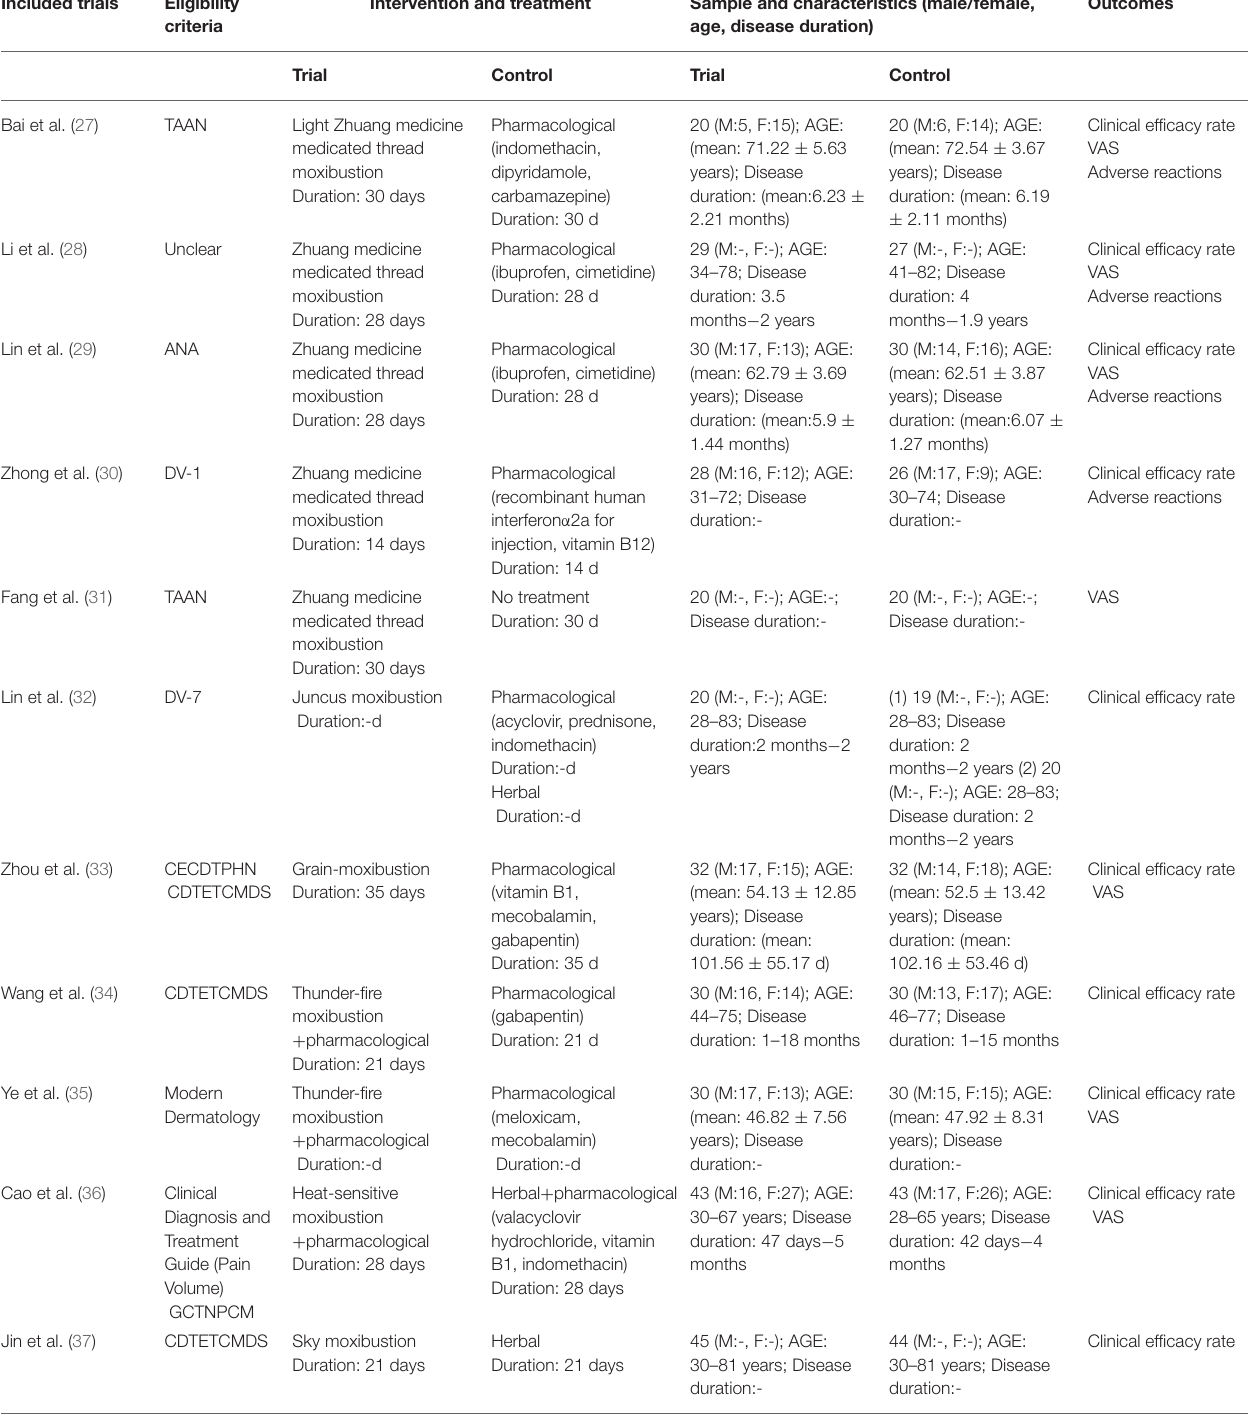
TABLE 1 | The characteristics of the randomized controlled trials (RCTs) included in this meta-analysis. Included